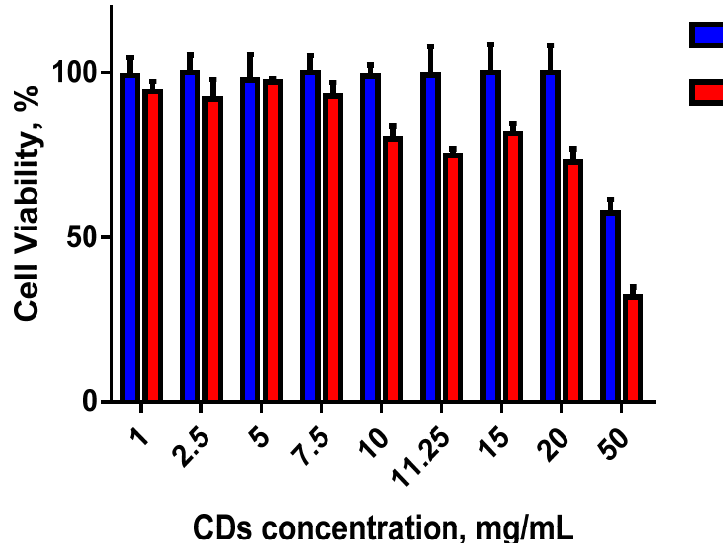
Figure 5. Cell viability screening performed on BALB/3T3 cell line clone A31, exposed for 4 h to HP- β -CD or HP- β -CD-SH in the 1–50 mg/mL concentration range. Untreated cells were used as control. The values indicated in the figure are means ± SD of 6 replicates.